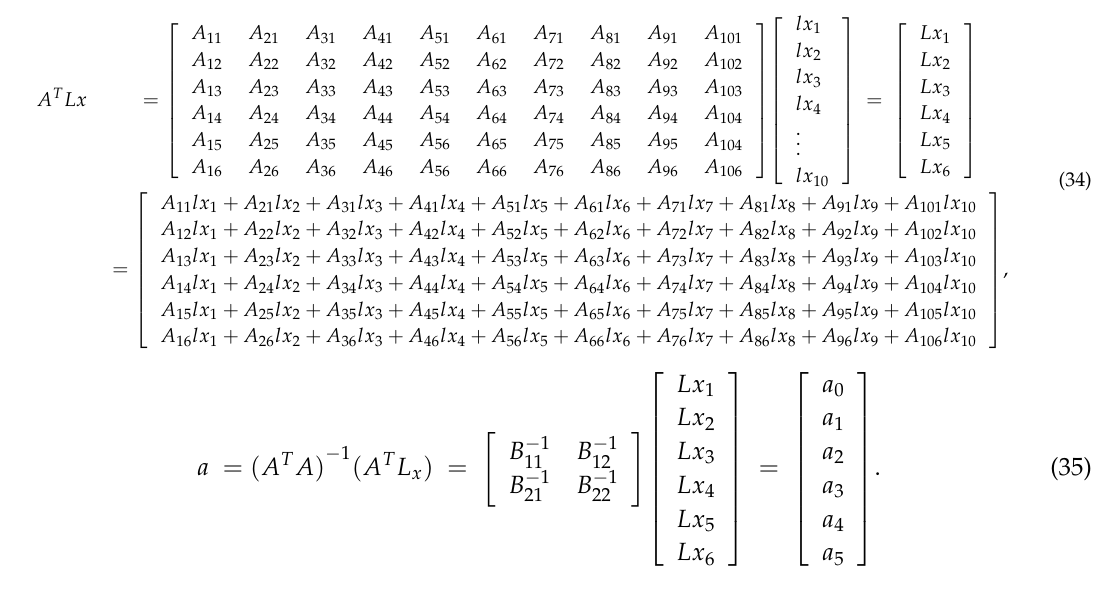
2 − . In Figure 15, the symbol "<<"